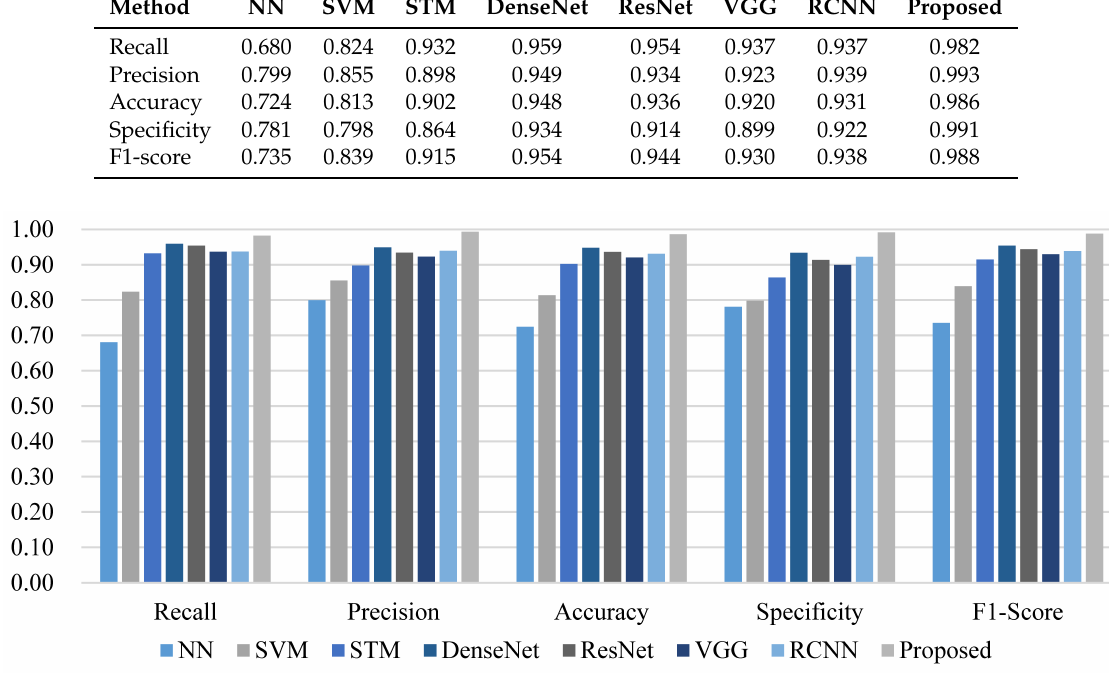
Figure 7. Classification performance comparison of different methods.